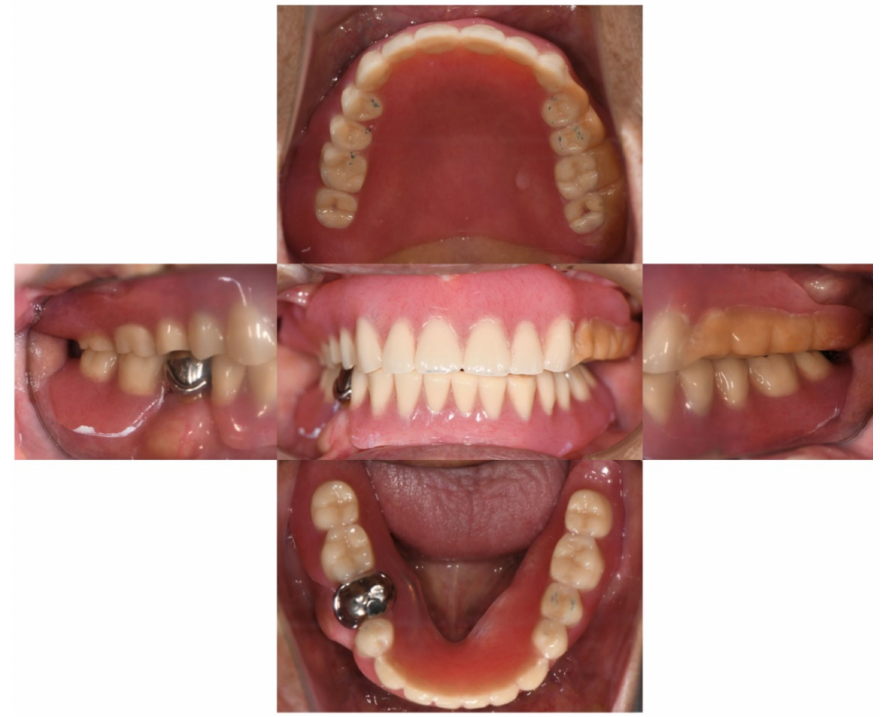
Figure 6. The intra-oral photo of the delivered prostheses. The shortened denture flange was obvious around the left tuberosity